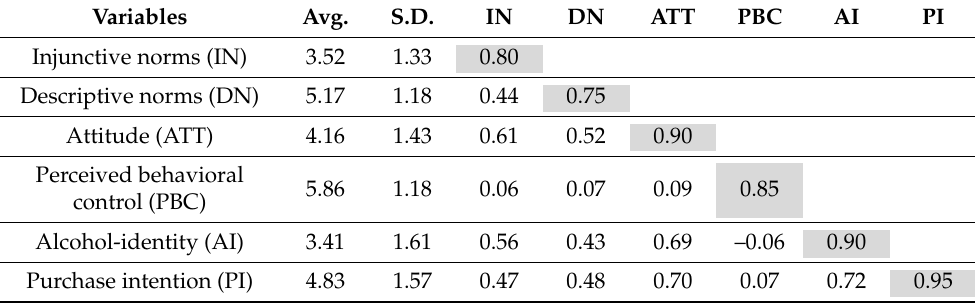
Table 3. Correlations among the latent